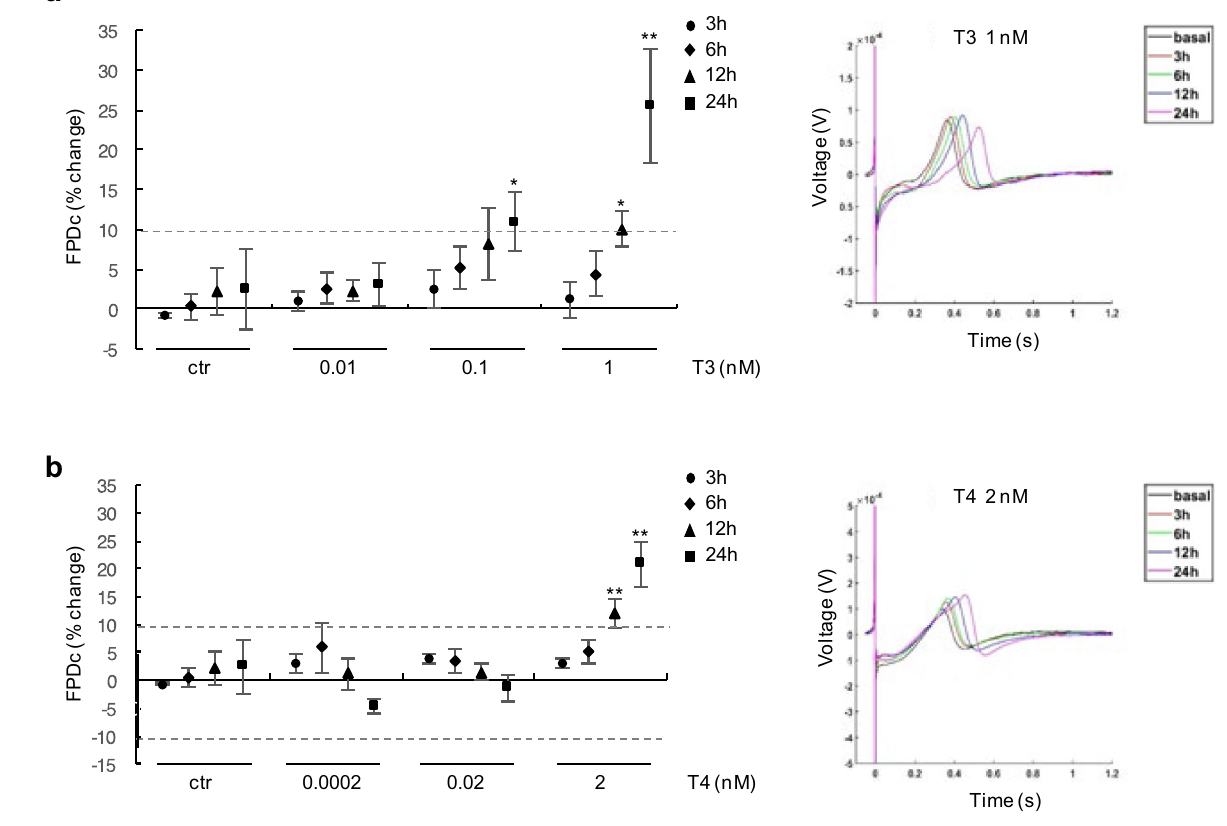
Figure 3. Effect of physiological doses of THs on FPDc in hiPSC-CMs. ( a ) left panel: analysis of FPDc in hiPSC-CMs treated for 3, 6, 12 and 24 h with T3 at different doses (0.01 nM, 0.1 nM, 1 nM) compared with vehicle treated cells (ctr); data are expressed as the percentage change of FPDc compared to baseline values; right panel: representative extracted FPD waveforms of hiPSC-CMs treated with 1 nM T3 at the indicated times. ( b ) left panel: analysis of FPD in hiPSC-CMs treated for 3, 6, 12 and 24 h with T4 at different doses (0.0002 nM, 0.02 nM, 2 nM), compared with vehicle treated cells (ctr); data are expressed as the percentage change of FPDc compared to baseline values; right panel: extracted FPD waveforms of hiPSC-CMs treated with 2 nM T4 at the indicated times. *p < 0.05 and **p <